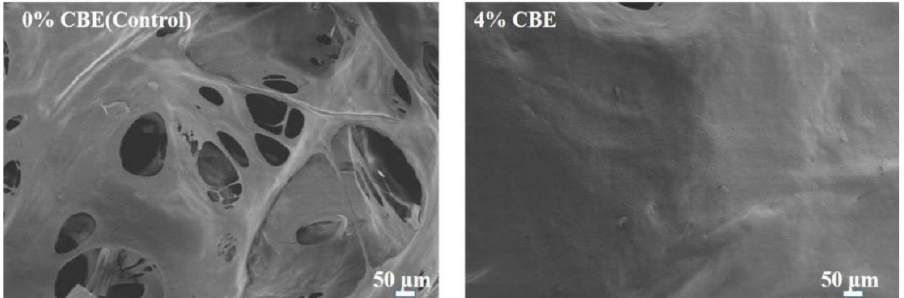
Figure 6. SEM images of fracture surfaces of the cured soybean protein ‐ based adhesives.